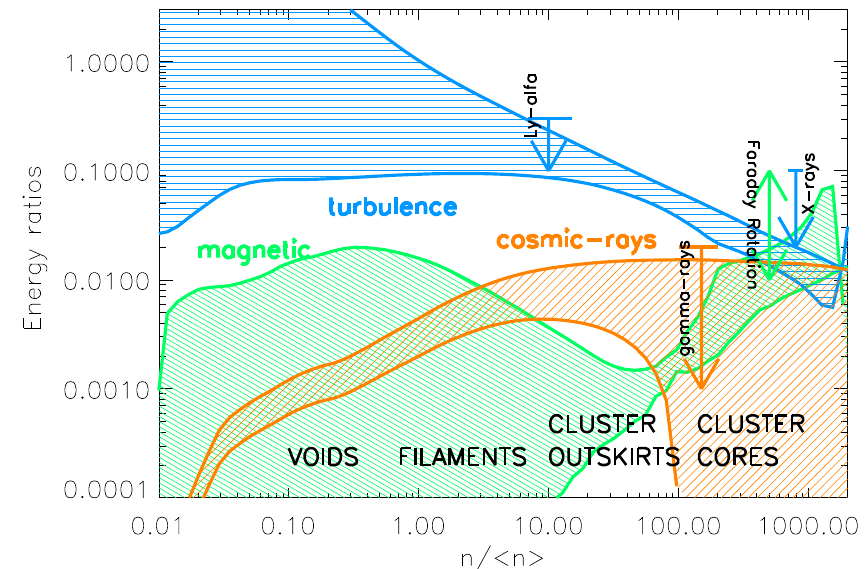
Figure 3. Distribution of NT energies as a function of cosmic environment for a 50 3 Mpc 3 volume at z = 0, normalised to the thermal energy within each density bin. The additional arrows show the available observational constraints for each energy field (see text for